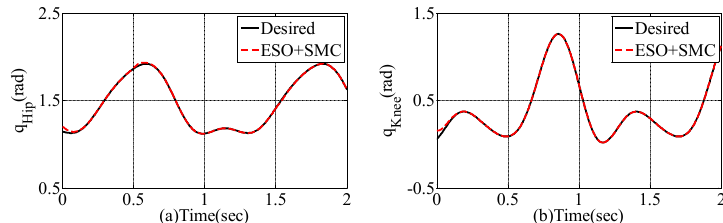
Figure 10. Joint angle tracking of the hybrid phase: ( a ) Hip joint; ( b ) Knee joint.